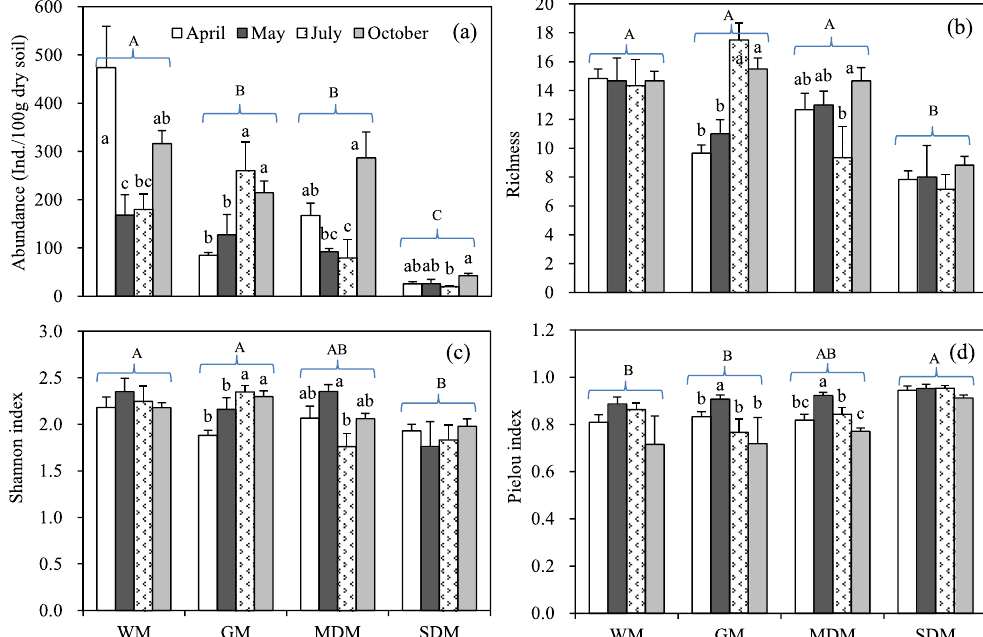
Figure 4. Spatio-temporal variations in abundance ( a ), richness ( b ), Shannon diversity ( c ) and Pielou index ( d ) of the soil nematode communities (mean + SE). Lower-case letters indicate temporal differences within habitats at the P < 0.05 level.